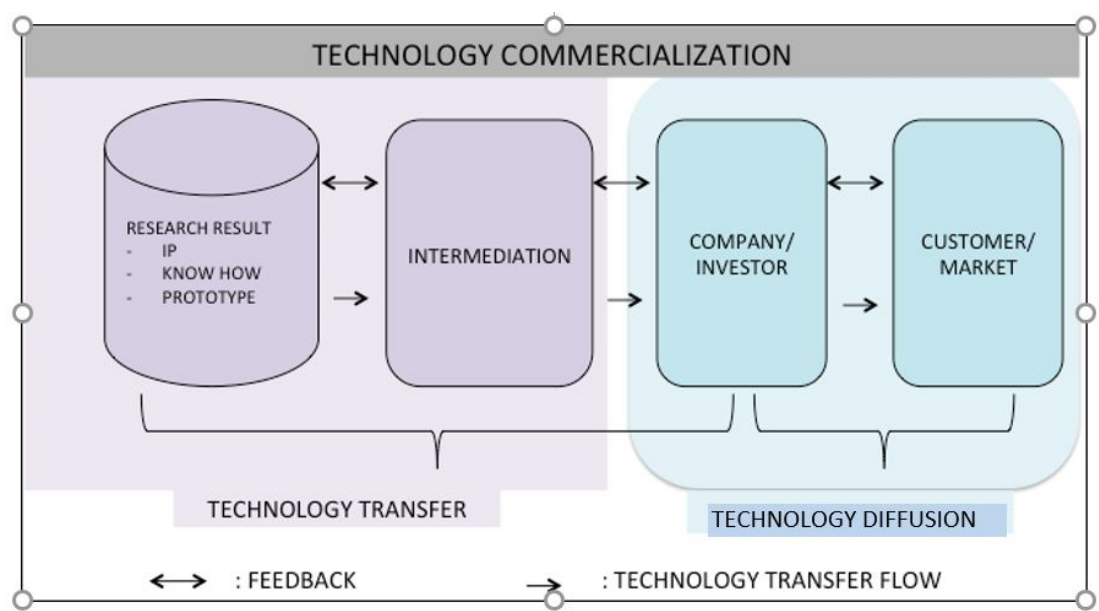
Figure 2. Science–technology transfer and innovation diffusion process.